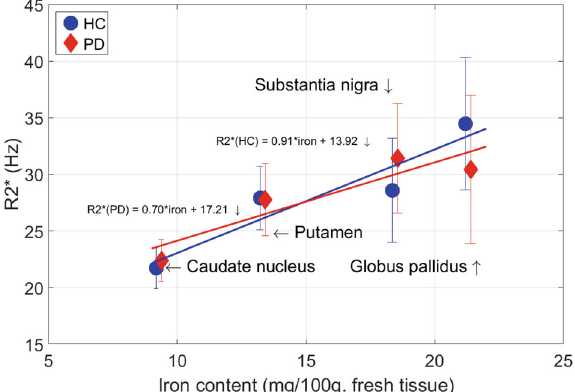
Fig. 3 Correlation between published regional brain iron content and regional R2* values of the present study. R2* values extracted from our iron-sensitive MRI data were related to regional brain iron content measured from non-PD post mortem brains, as published by Hallgren and Sourander 21